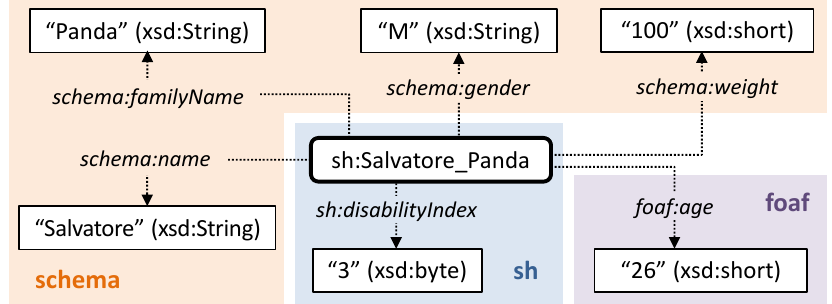
Figure 5. Example of context-aware attributes modeling for patients.